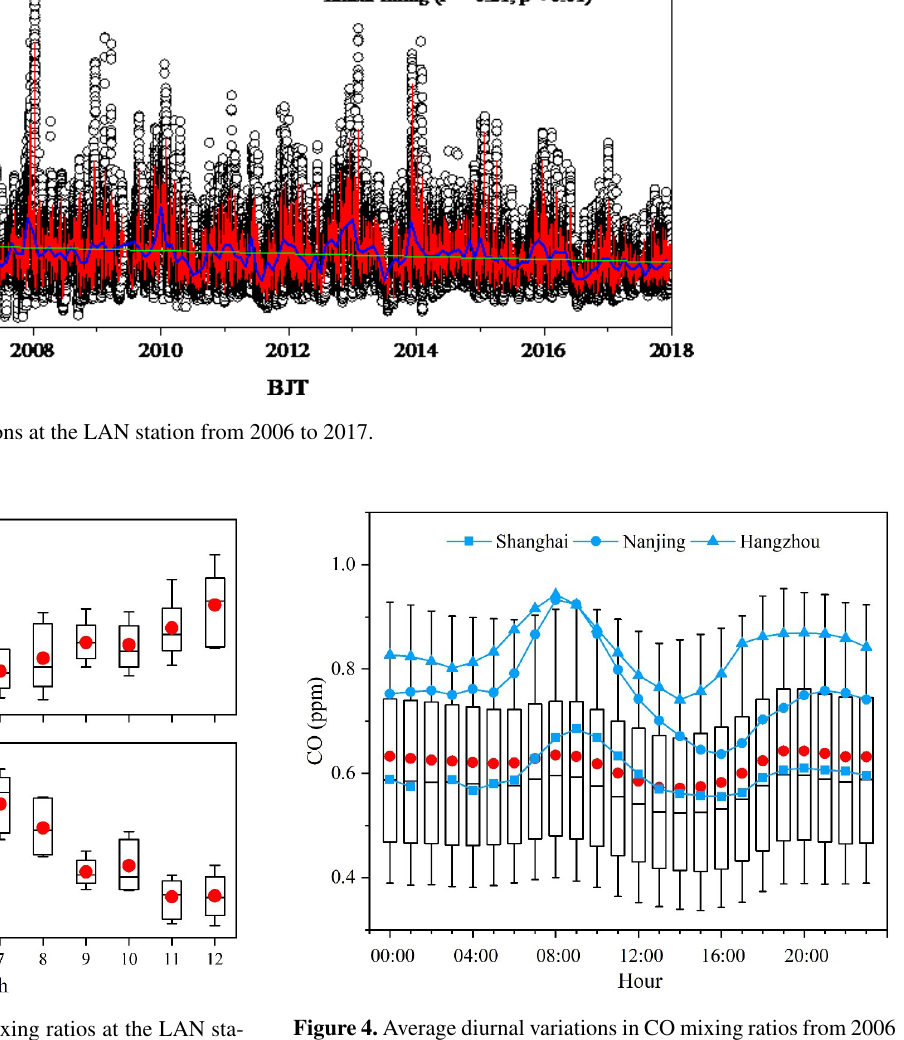
Figure 3. Seasonal variations in CO mixing ratios at the LAN sta- tion and the number of fire spots in the YRD region from 2006 to 2017. The lines and dots in the box are the median and mean con- centrations, respectively; the box’s lower and upper limits represent 25th and 75th percentile concentration ranges, respectively; and the lower and upper whiskers correspond to the 10th and 90th percentile values.